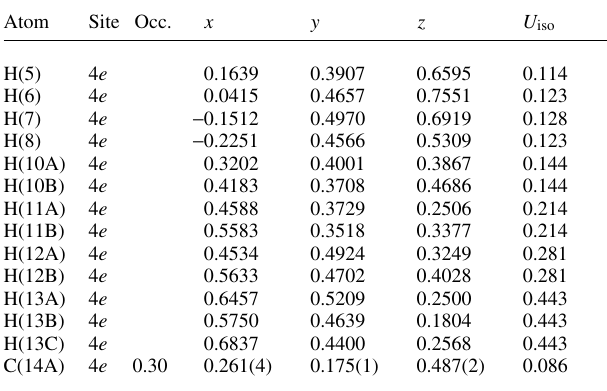
Table 2. Atomic coordinates and displacement parameters (in Å 2 )